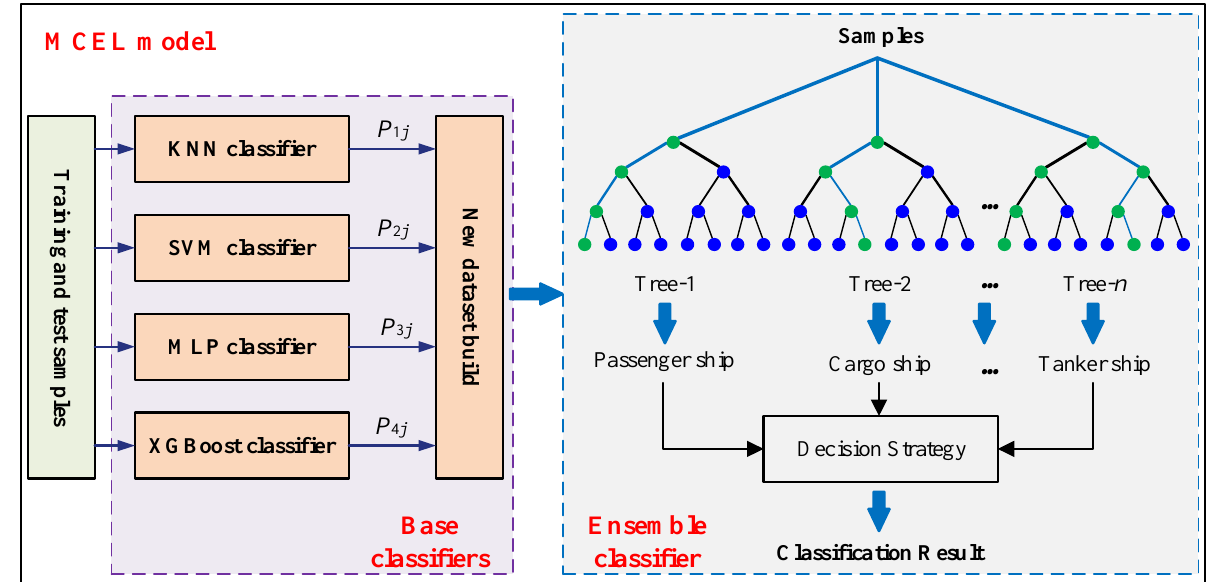
Figure 7. The overall framework of the multiple classifiers ensemble learning model.